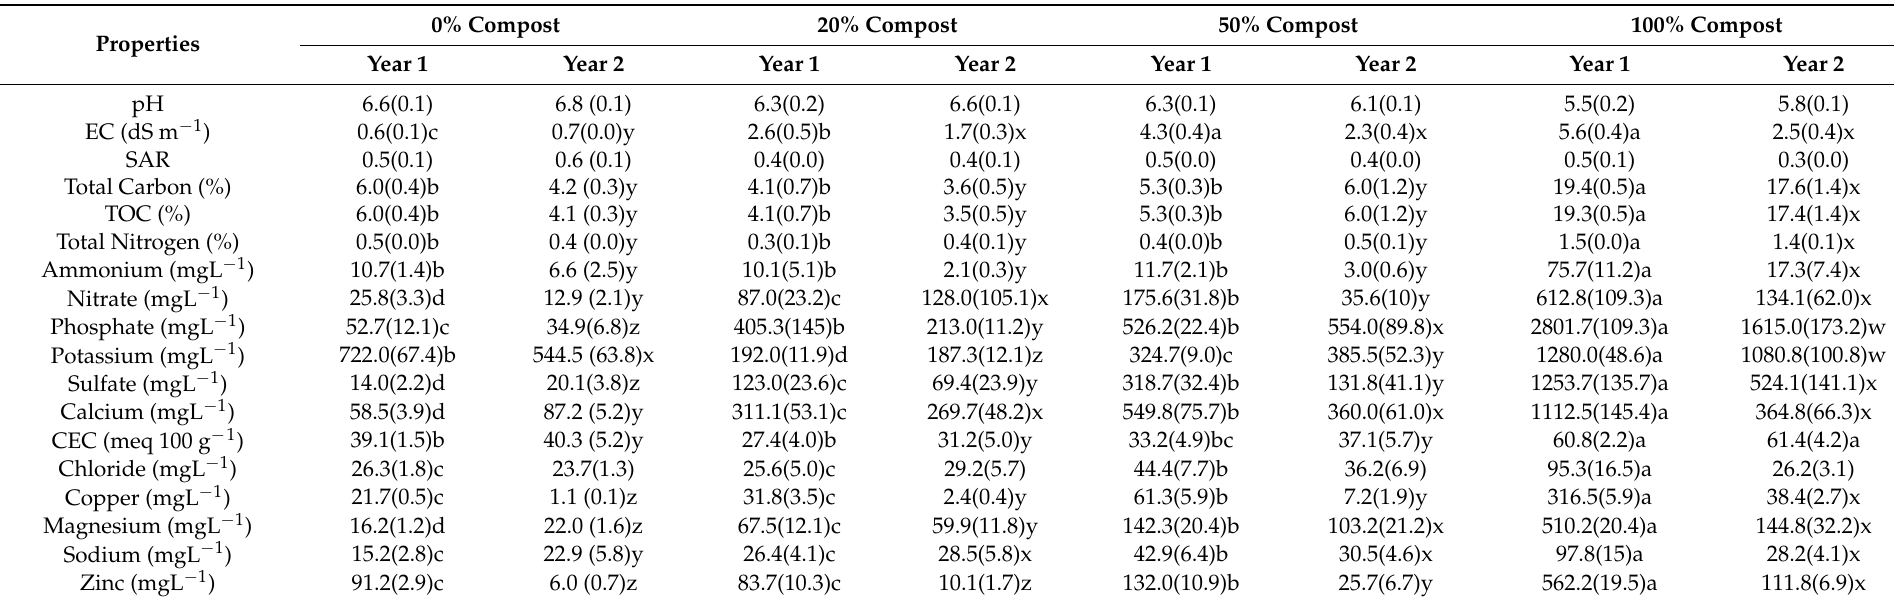
Table 1. Mean ( ± SE) soil properties by soil amendment treatments. Different letters indicate significant differences among amendment treatments in individual years at α = 0.05. EC= Electrical Conductivity, SAR = Sodium Adsorption Ratio, TOC = Total Organic Carbon, CE ation Exchange